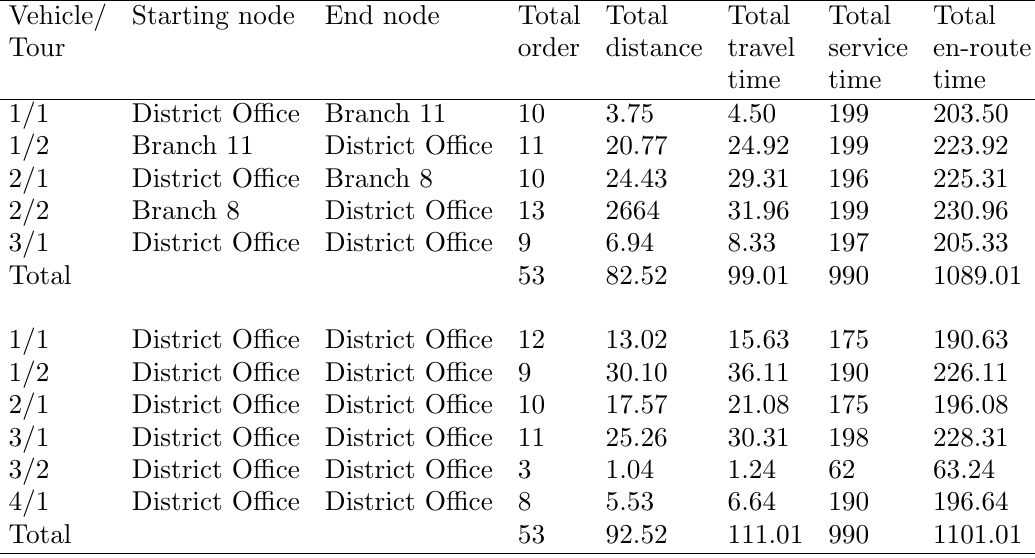
Table 6. The detailed results of instance